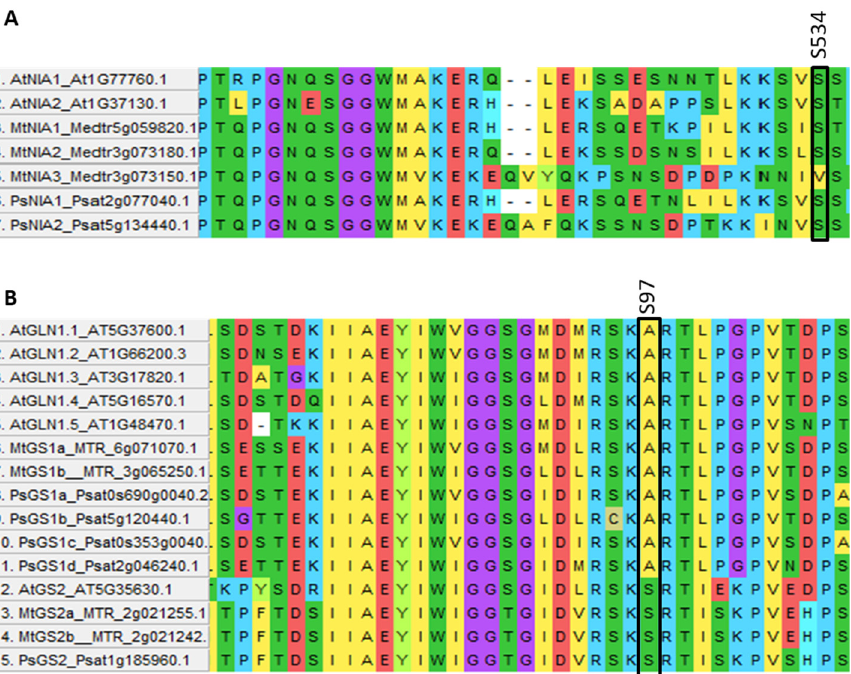
Figure 3. Phosphorylation site variation in NIA ( A ) and GS ( B ) proteins at S534 and S97 ( boxed ).